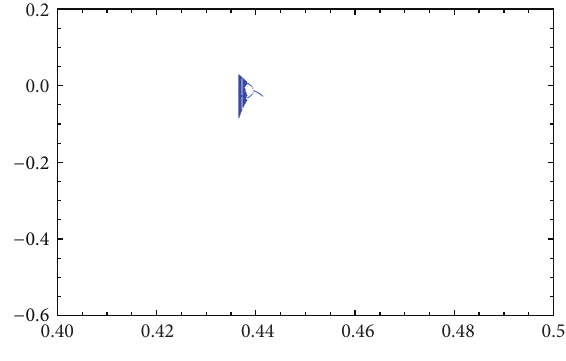
Figure 19: Feigembaun diagram for 𝜆 = 0.5